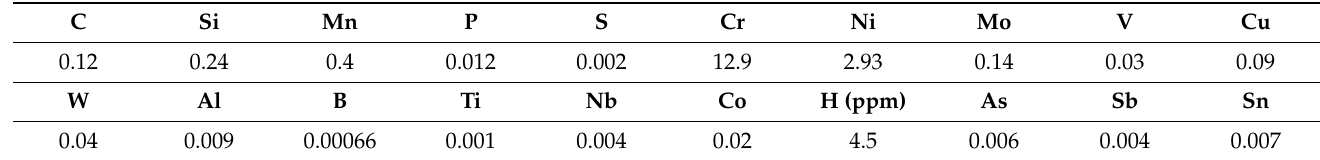
Table 1. Chemical composition of